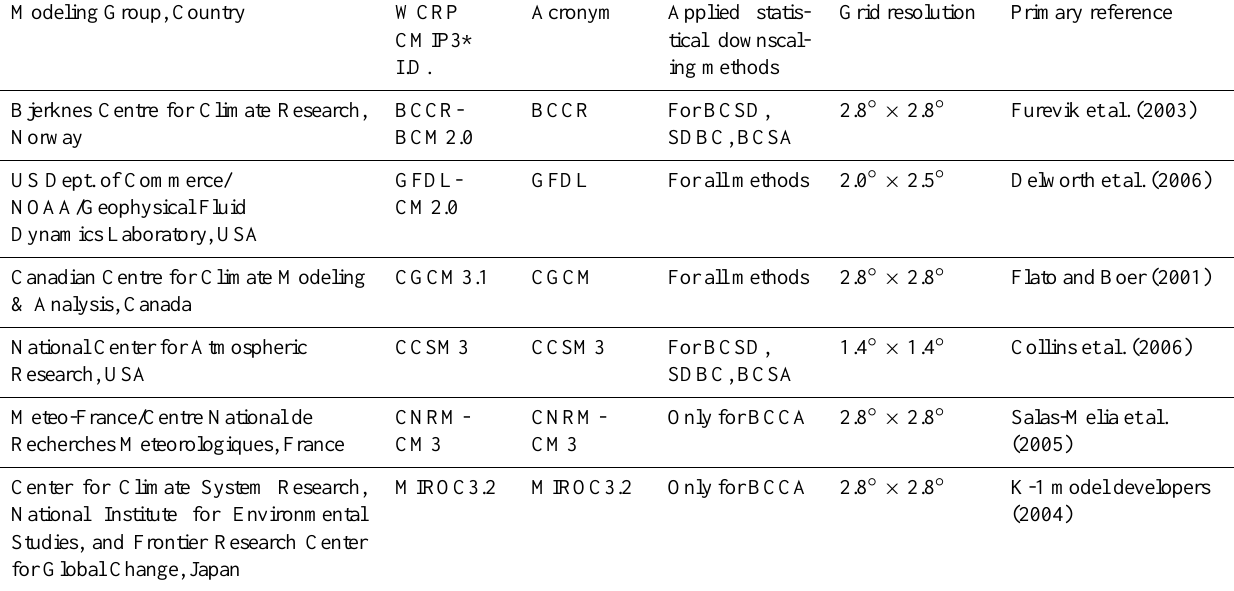
Table 1. GCMs used in this